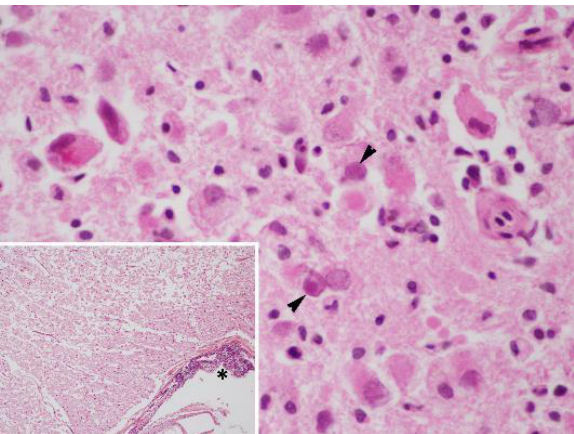
Figure 5. Brain cerebral cortex sample of case 11, a female of Atlantic spotted dolphin calf co-infected with Brucella sp., presenting 6/7 of the evaluated brain lesions. Multiple amphophilic intranuclear inclusion bodies within neurons (arrowheads) and satellitosis are present. Original magnification ×60; haematoxylin and eosin staining. Inset: medulla oblongata sample of case No 11. Moderate non-